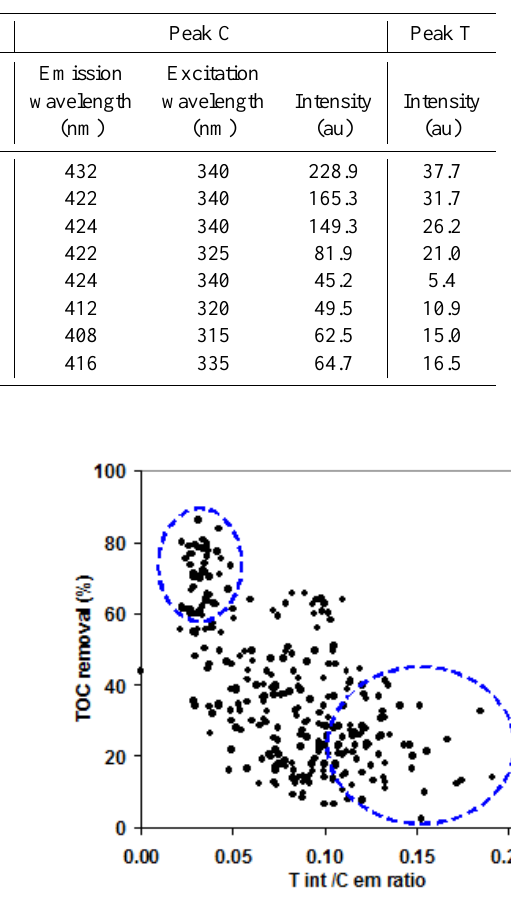
Figure 3. Peak T intensity / peak C emission wavelength ratio vs. TOC removal e ffi ciency. Circles indicate two fluorescence end-